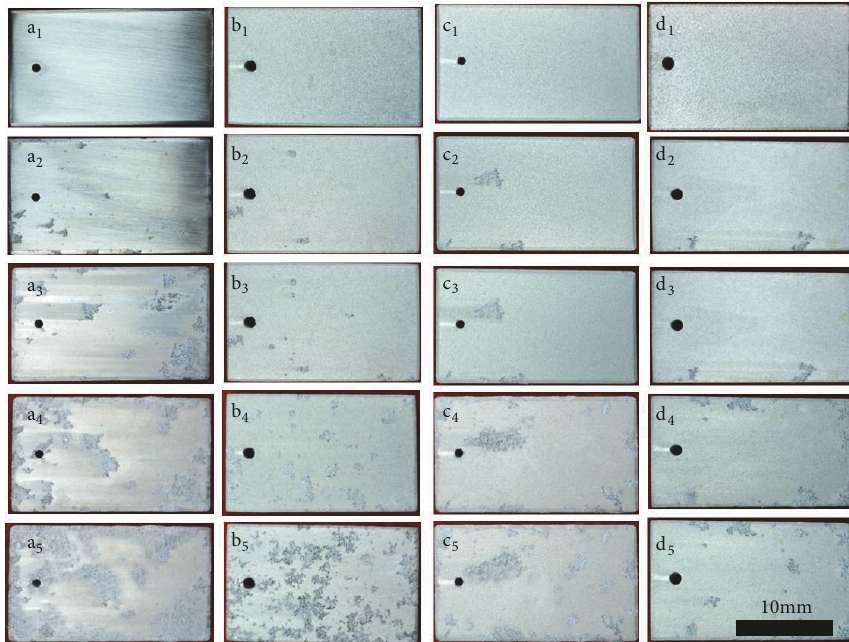
Figure 9: Optical corrosion morphologies of the AZ91D alloy with and without conversion coating of immersing test in 0.6M NaCl: (a 1 ) nonimmersed original sample, (a 2 ) original sample immersed for 24h, (a 3 ) original sample immersed for 48h, (a 4 ) original sample immersed for 72h, (a 5 ) original sample immersed for 120h, (b 1 ) nonimmersed CO 2 24h sample, (b 2 ) CO 2 24h sample immersed for 24h, (b 3 ) CO 2 24h sample immersed for 48h, (b 4 ) CO 2 24h sample immersed for 72h, (b 5 ) CO 2 24h sample immersed for 120h, (c 1 ) nonimmersed CO 2 2h /pH11.5 2h sample, (c 2 ) CO 2 2h/pH11.5 2h sample immersed for 24h, (c 3 ) CO 2 2h /pH11.5 2h sample immersed for 48h, (c 4 ) CO 2 2h /pH11.5 2h sample immersed for 72h, (c 5 ) CO 2 2h /pH11.5 2h sample immersed for 120h, (d 1 ) nonimmersed CO 2 3MPa 0.5h sample, (d 2 ) CO 2 3MPa 0.5h sample immersed for 24h, (d 3 ) CO 2 3MPa 0.5h sample immersed for 48h, (d 4 ) CO 2 3MPa 0.5h sample immersed for 72h,